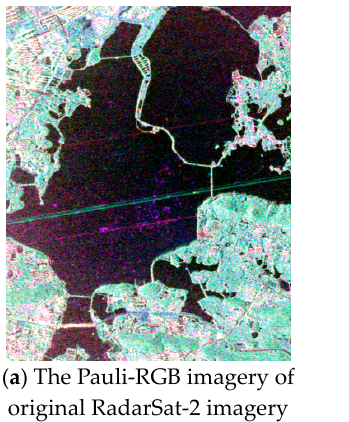
Figure 14. The Pauli-RGB imagery of UAVSAR after speckle filtering and GSRM segmentation: ( a ) The Pauli-RGB imagery of original RadarSat-2 imagery; ( b ) The Pauli-RGB imagery of RadarSat-2 after speckle filtering; ( c ) The Pauli-RGB imagery of RadarSat-2 after GSRM segmentation.